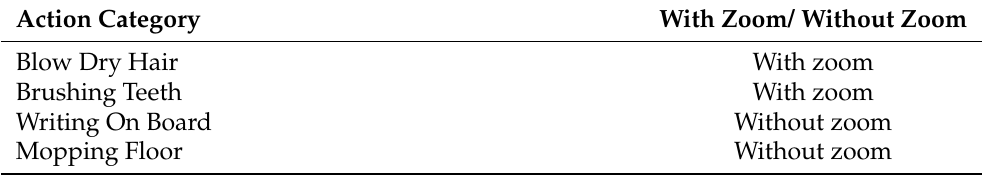
Figure 7. Upon detecting the face of the user, the model zooms in on it to create the video clip that is passed to the OAD model. Table 1. The four categories of actions and their status regarding